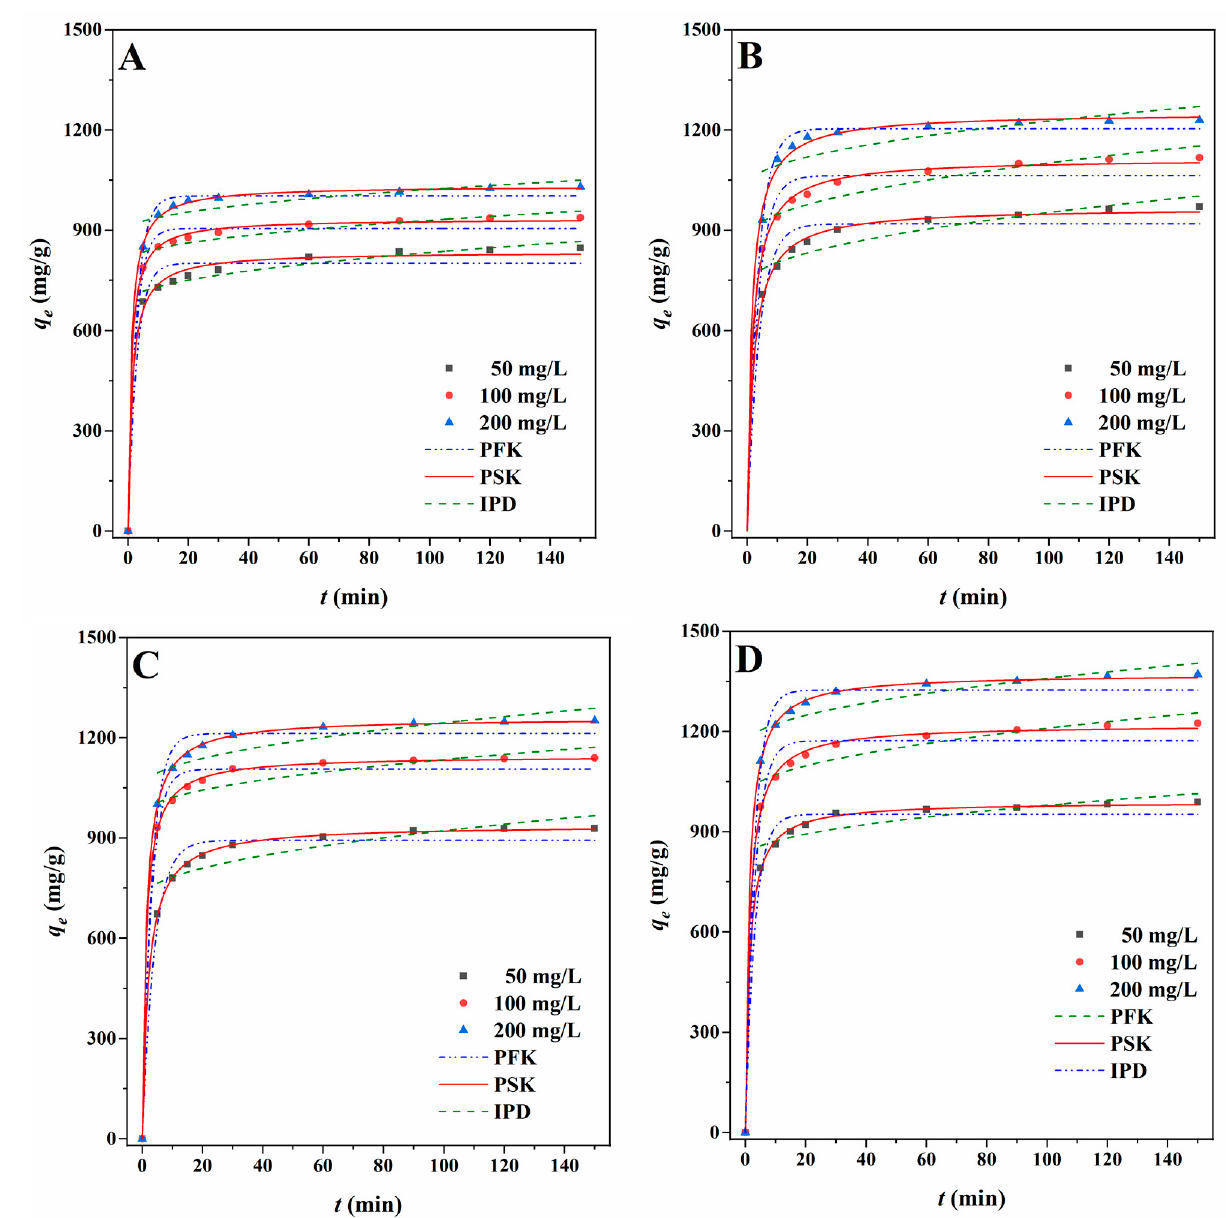
Figure 5. PFK, PSK, and IPD plots of RhB and TH for ITGB ( A , B ) and MITGB ( C , D ) at 303 K. The effect of concentration on the adsorption capacity of an adsorbent always is studied by investigating the adsorption isotherms [39,40]. Different initial concentrations Table 2. Fitting parameters of adsorption kinetic models for RhB and TH at 303 K. of solutions were used to explore the behaviors between the adsorbent (ITGB and MITGB) and the adsorbate (RhB and TH) during the processes at 303 K as shown in Figure 6. As can be seen from the results that the adsorption capacities of samples were increased with the increase in the initial concentrations solutions. Langmuir isotherm and Freundlich isotherm models were used to investigate the experimental data as shown in Table